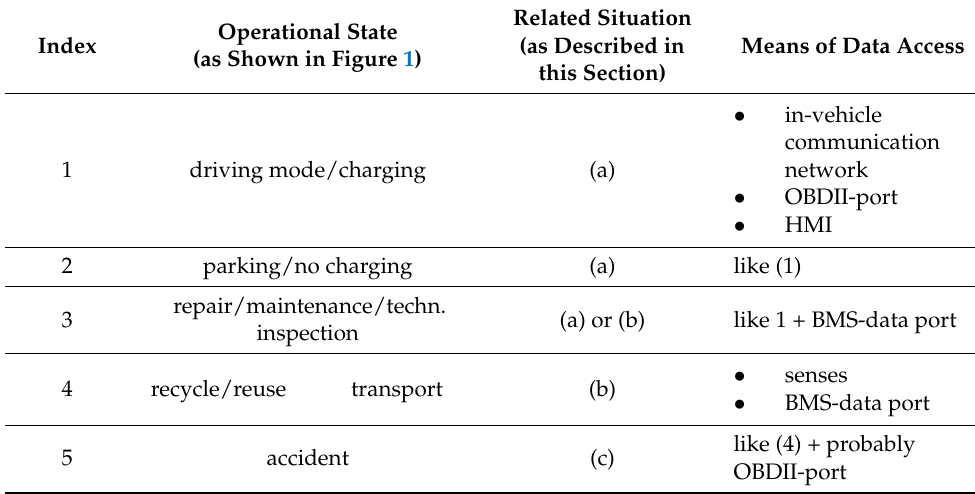
Table 2. Overview of operational states as shown in Figure 1 and means of battery-related data access linked to the vehicle/battery assembly